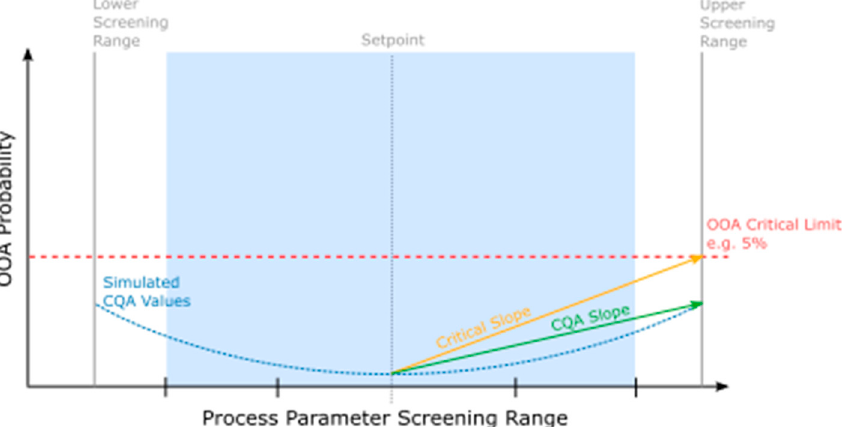
Figure 3. Example of FMEA linearization procedure. The shaded area represents the currently proposed manufacturing range.